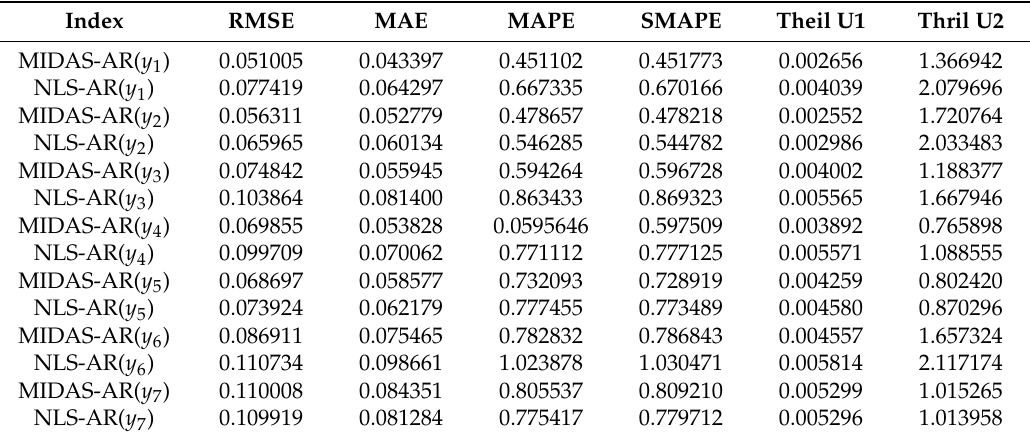
Table 4. Intra-sample prediction accuracy index values of mixed data regression model and nonlinear regression